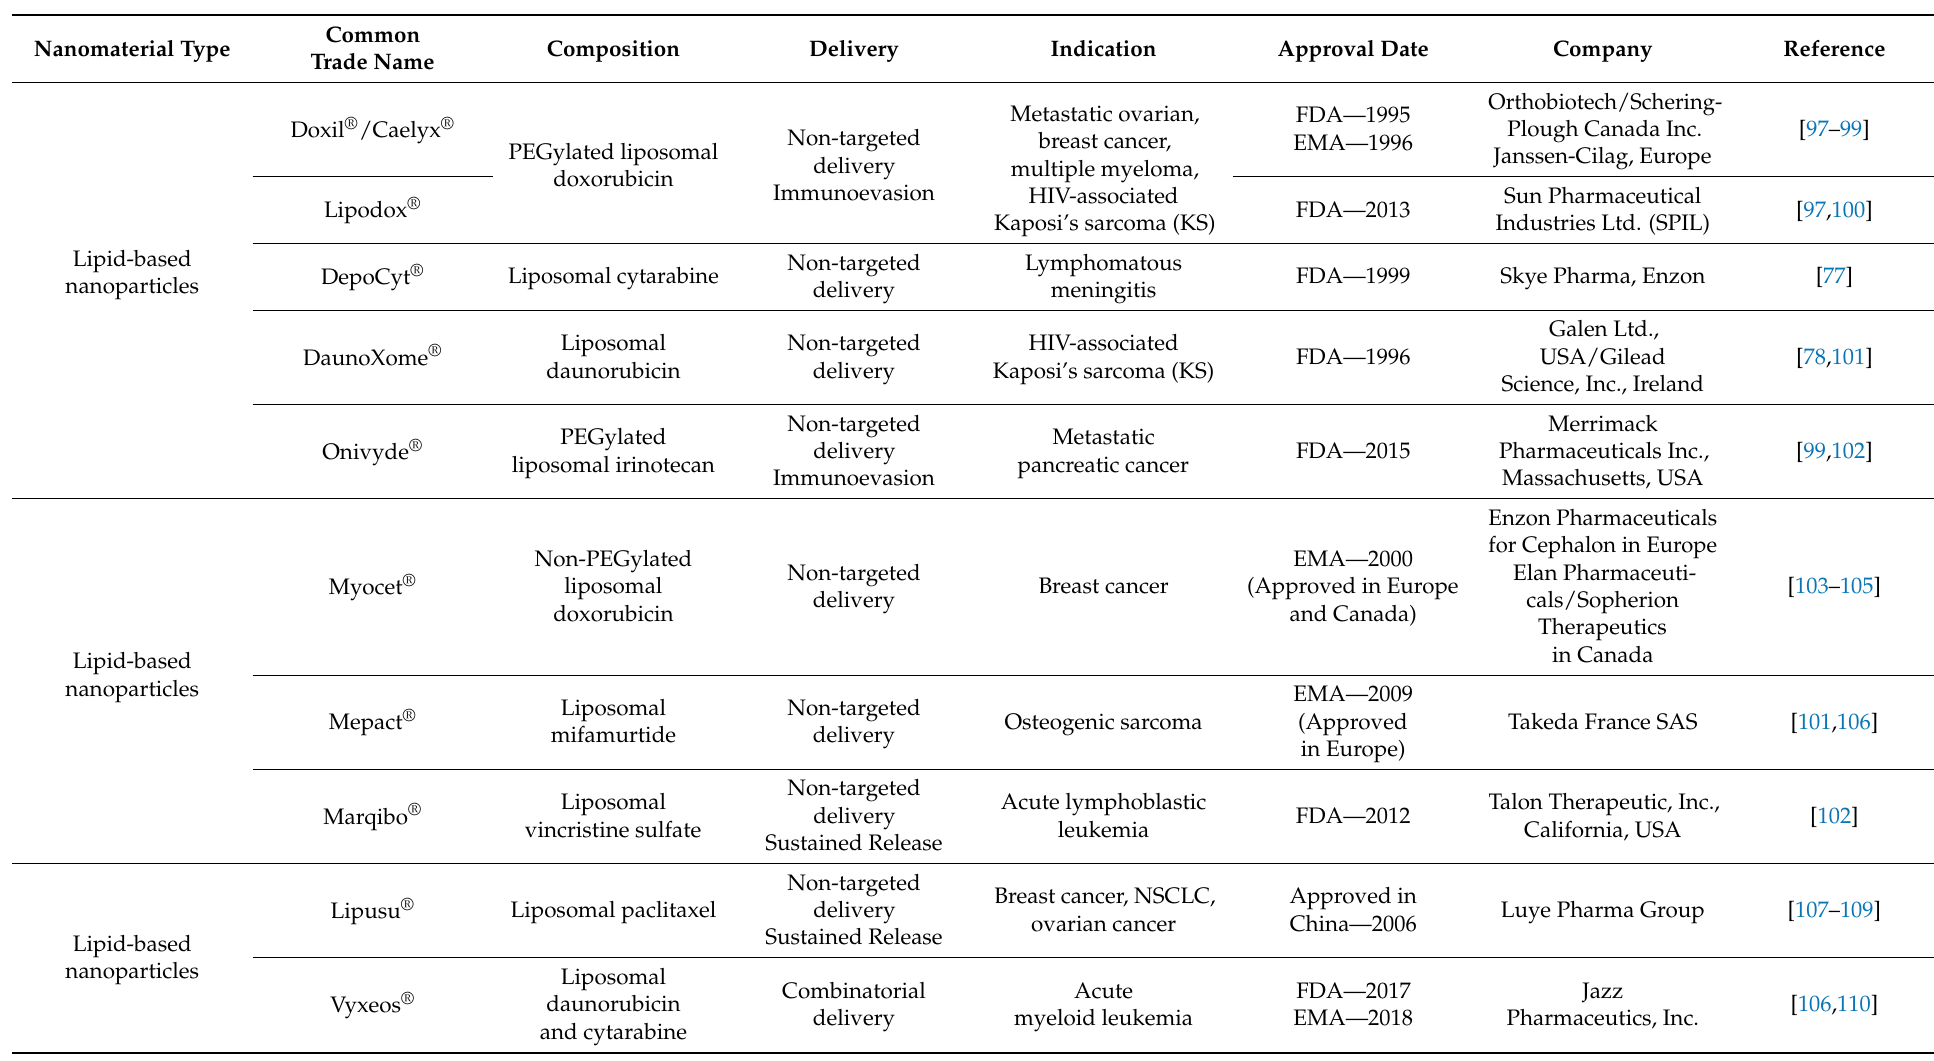
Table 2. Clinically approved and marketed nano-drugs for